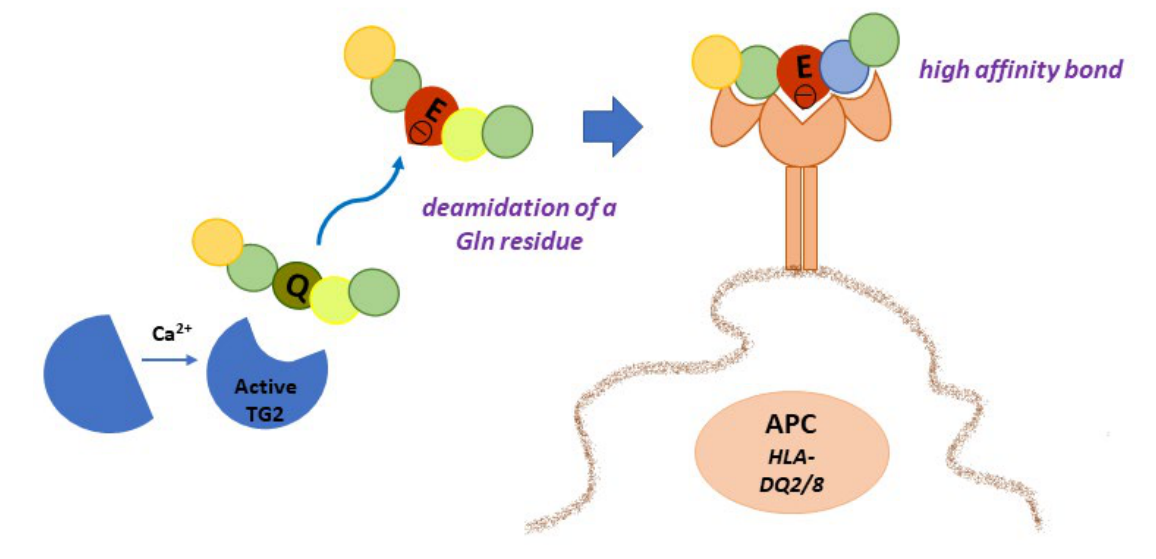
Figure 3. TG2 deamidation of a specific Gln residue in gliadin peptide introduces a net negative charge responsible for better recognition by DQ2/8 molecules on APC cells.